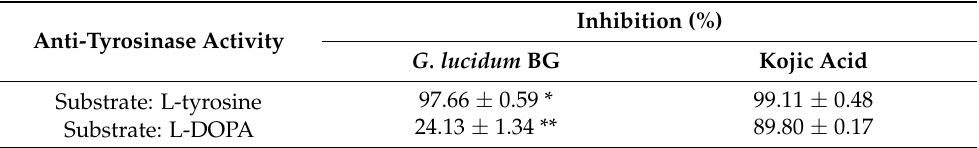
Table 3. Anti-tyrosinase activity of antler-type G. lucidum